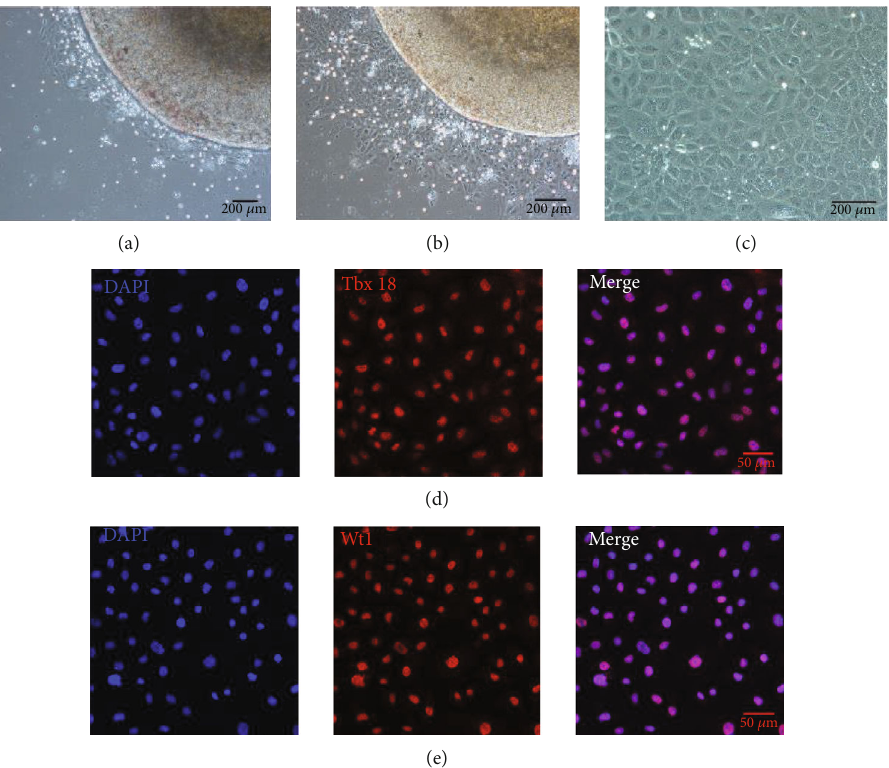
Figure 2: EPCs migrated out from the edge of embryonic mouse heart. (a) The cobblestone-like EPCs grew from the edge of the embryonic ventricular tissue after 24 hours ’ culture. (b) The cobblestone-like EPCs continued growing from the edge of the embryonic ventricular tissue after 48 hours ’ culture. (c) Cobblestone-like EPCs were observed after removing the ventricular tissue. (d, e) Immuno fl uorescence staining showed all cultured EPCs expressed Tbx18 and